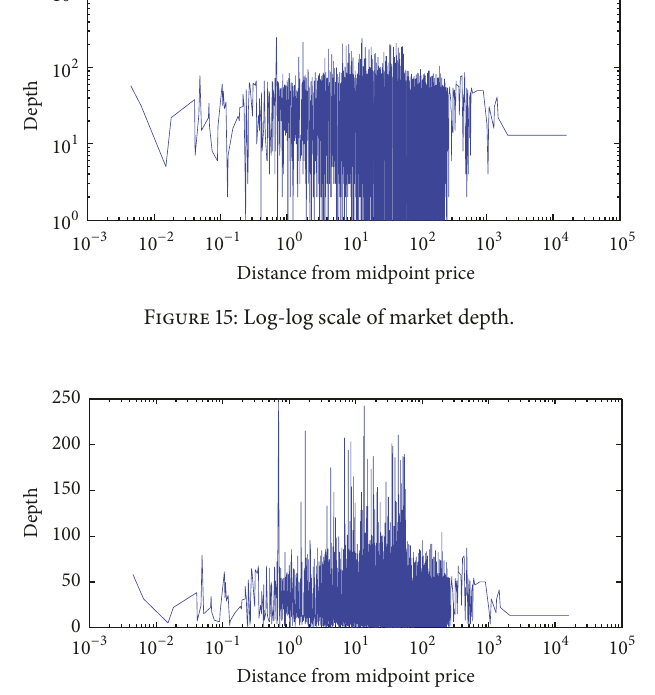
Figure 16: Log-linear scale of market